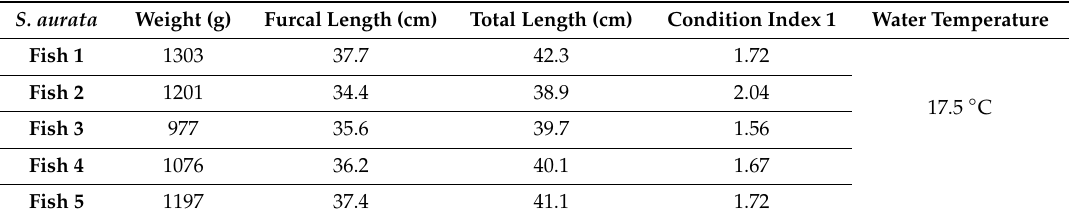
Table 1. Weight, furcal length, total length and condition index of the five S. aurata collected in March 2018, as well as the water temperature of the land tank from fish farming pilot station in the south of